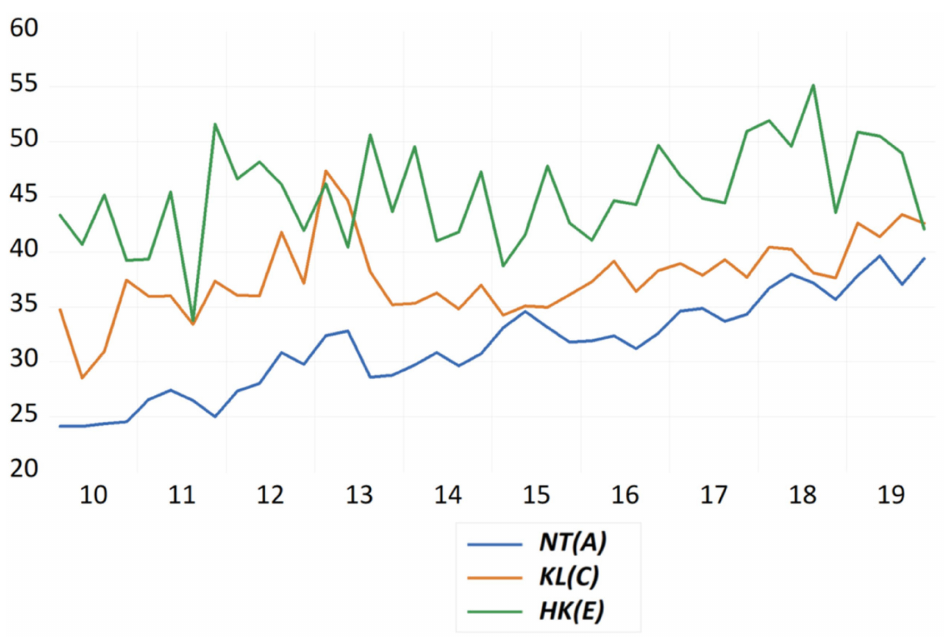
Figure 3. PtR ratios of the three sample